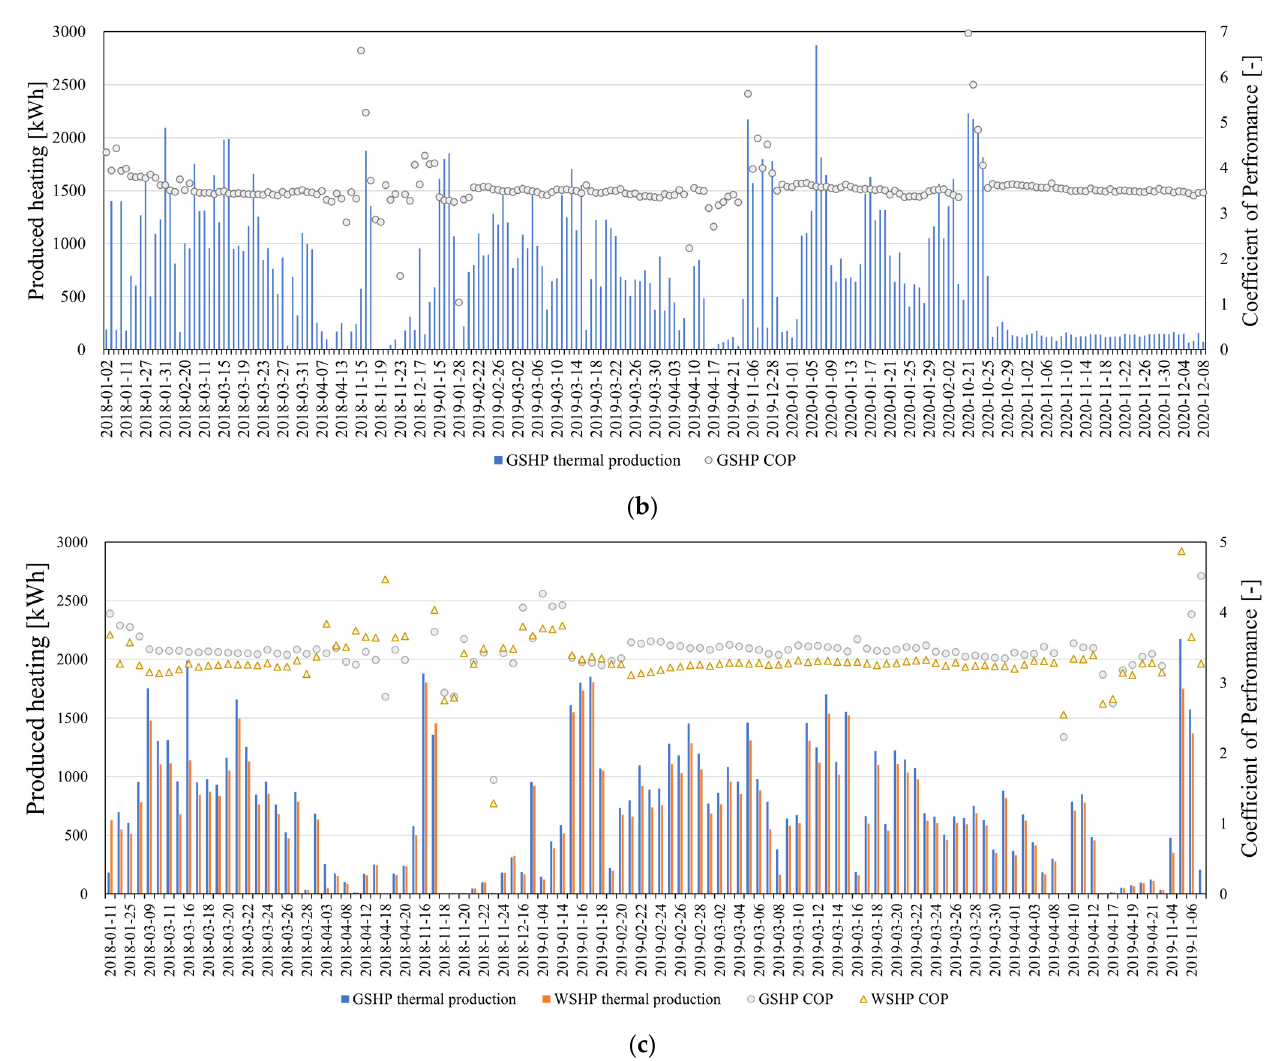
Figure 9. Operation results of the heat pump systems during the heating season: ( a ) operation of SWSHP; ( b ) operation of GSHP; and ( c ) simultaneous operation results of GSHP and SWSHP in series.